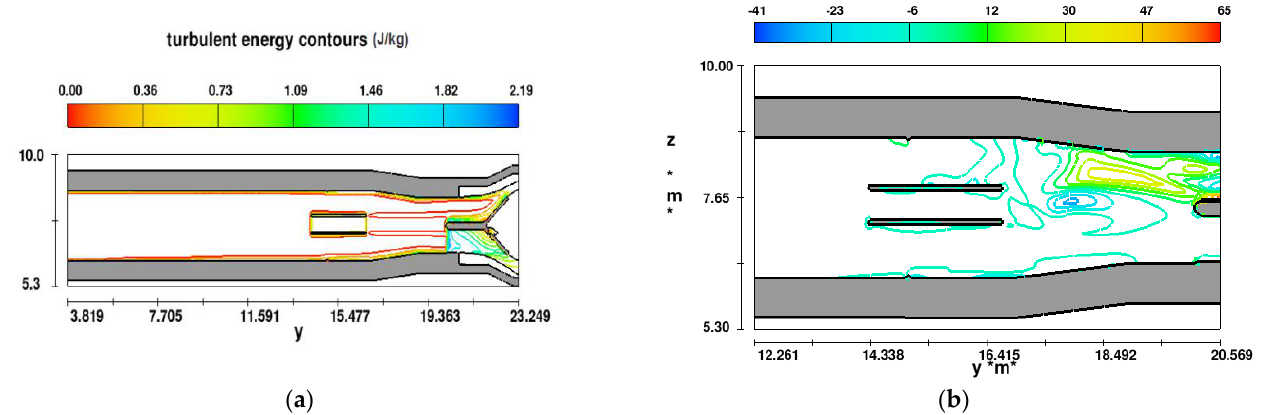
Figure 7. ( a ) sectional view of turbulent energy contours for the longitudinal distance between two valves = 2D; and ( b ) vorticity contours.